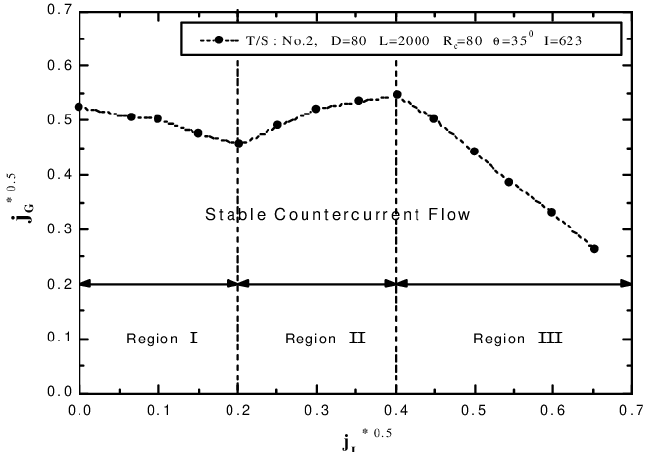
Figure 8. Typical CCFL curve (Kang et al. [11]).